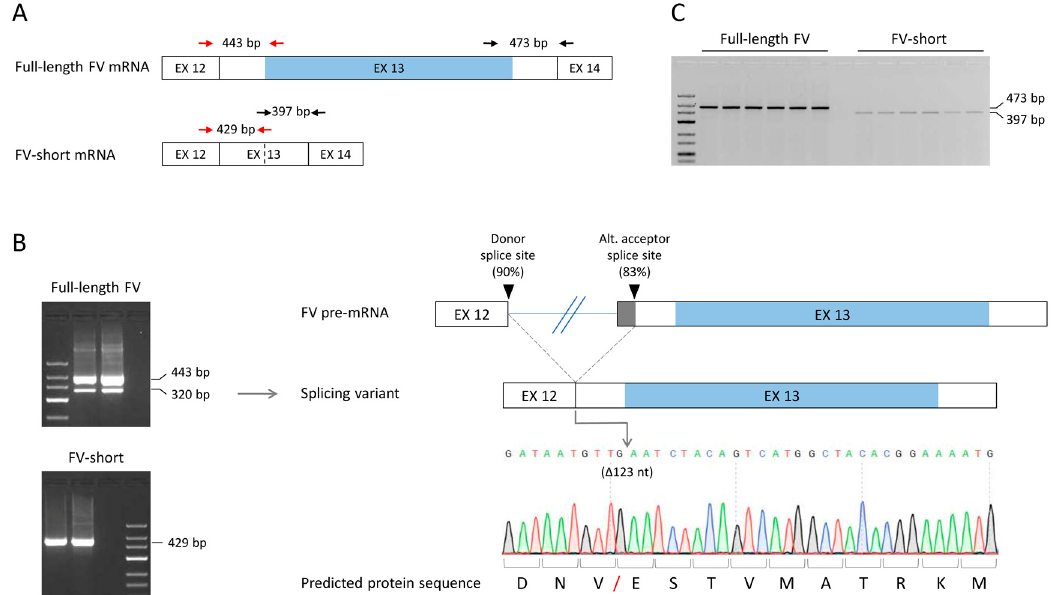
Figure 3. Amplification of FV transcripts and identification of a new alternatively spliced transcript. ( A ) Schematic representation of the region spanning F5 exons 12–14 in the full-length FV and FV-short transcripts. The positions of the primers used to amplify these transcripts (first primer set in red, second primer set in black) are shown and amplicon sizes are indicated. EX: exon. ( B ) Left: Typical PCR products obtained after amplification of HepG2 cDNA using the first (red) set of primers (note: since the unexpected 320-bp band was more prominent in qPCR than in normal PCR experiments, the figure shows a gel loaded with qPCR products). Right: Schematic representation and sequencing chromatogram of the new splicing variant lacking the first 123 nucleotides (nt.) of exon 13. The red forward slash in the protein sequence marks the position of the predicted 41-amino acid deletion. ( C ) Typical PCR products obtained after amplification of HepG2 cDNA using the second (black) set of